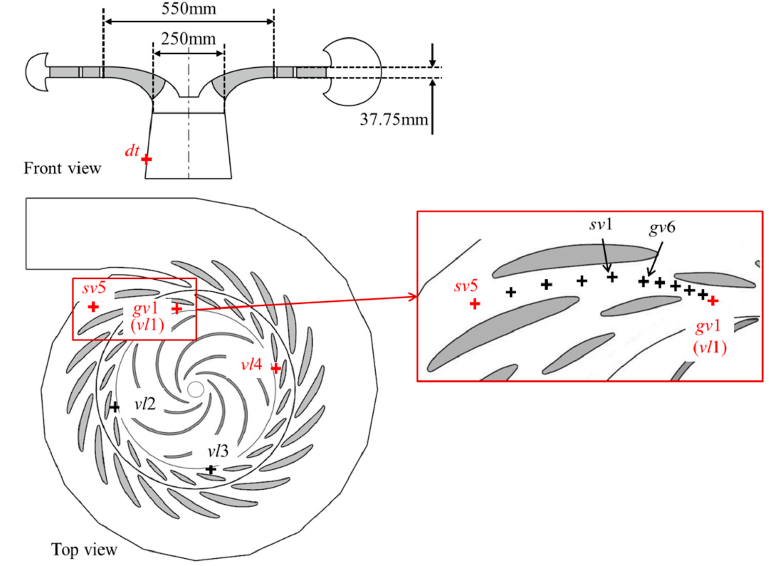
Figure 5. Static pressure monitoring points in the draft tube, the vaneless space, guide vane, and stay vane channels.